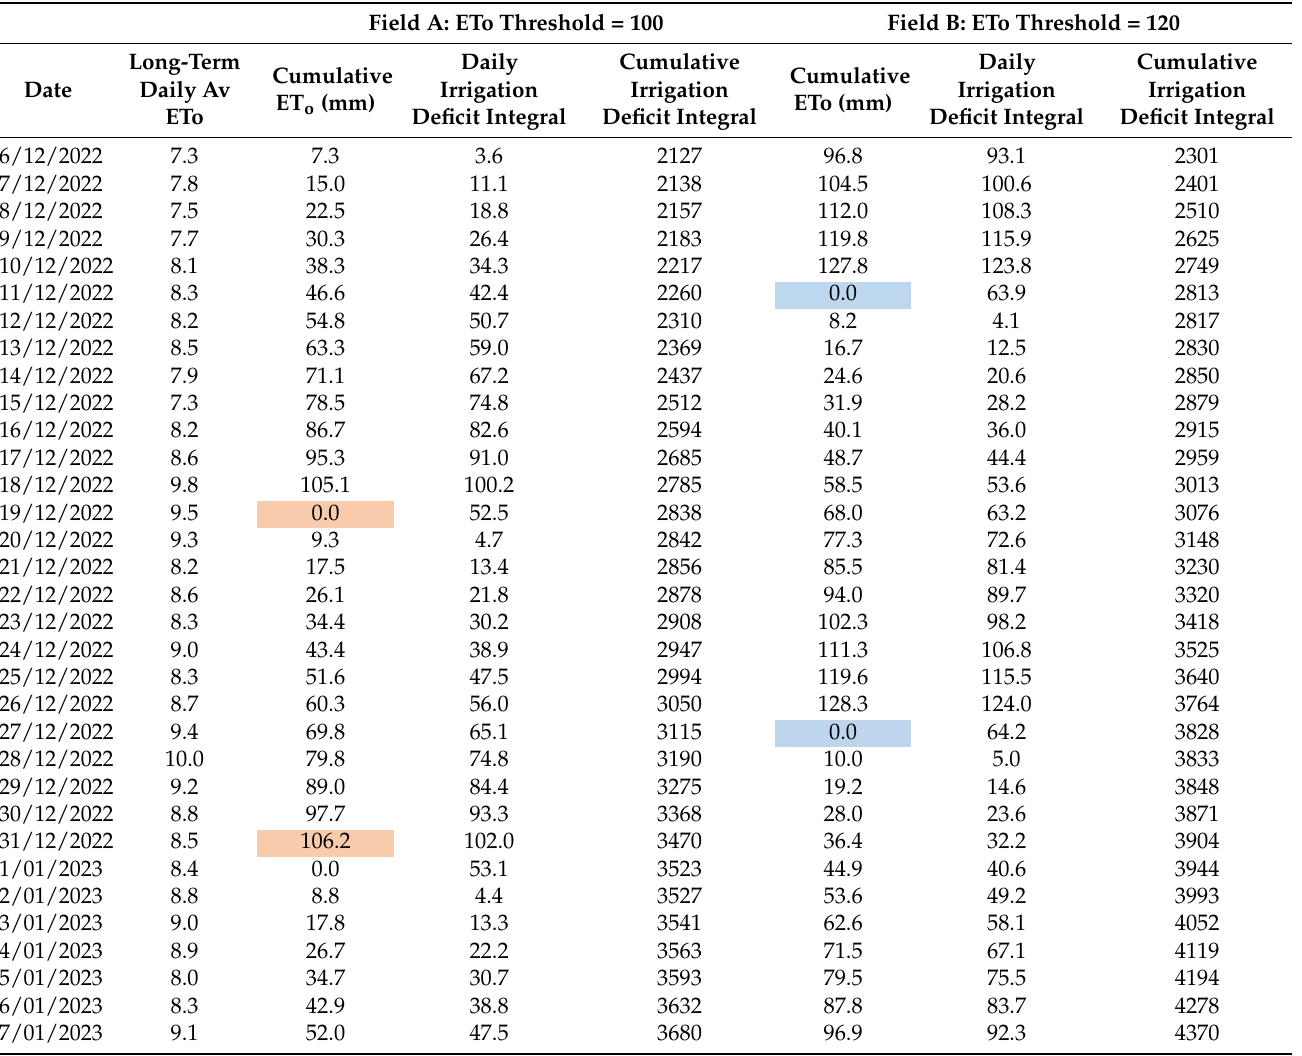
Table 2. Cont. Field A: ETo Threshold = 100 Field B: ETo Threshold = 120